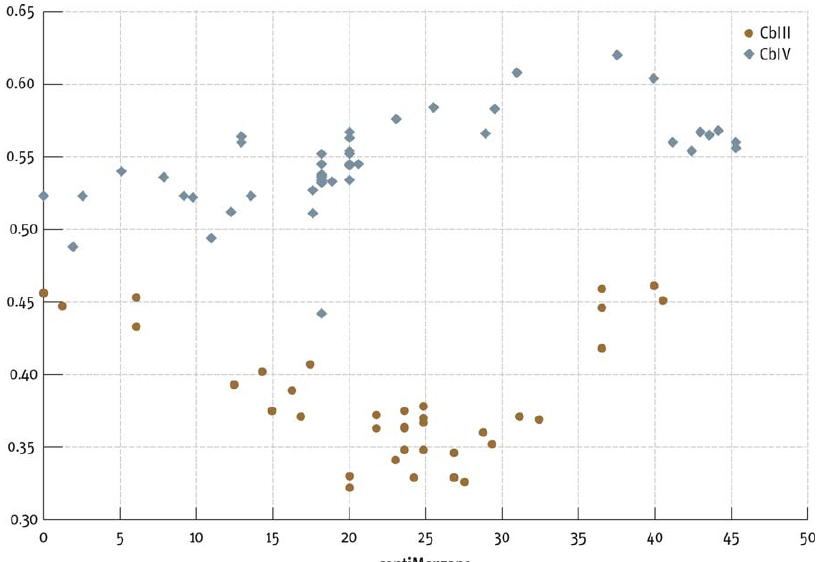
Figure 1. PercentRecoveryoftheAF16AlleleintheRILinesforEachoftheMarkersPlottedagainstItsPositionincMon C.briggsae ChromosomesCbIIIandCbIV Alleles from AF16 are less frequently recovered for much of CbIII, whereas for CbIV, the opposite holds. See Dataset S2 for other chromosomes.